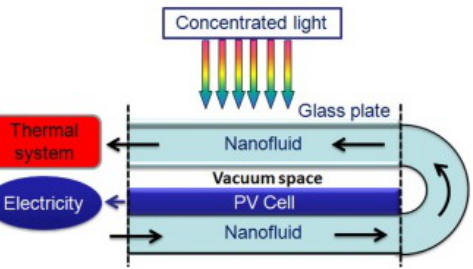
Figure 3. Schematic diagram of a nano-fluid based PV/T collector [31].